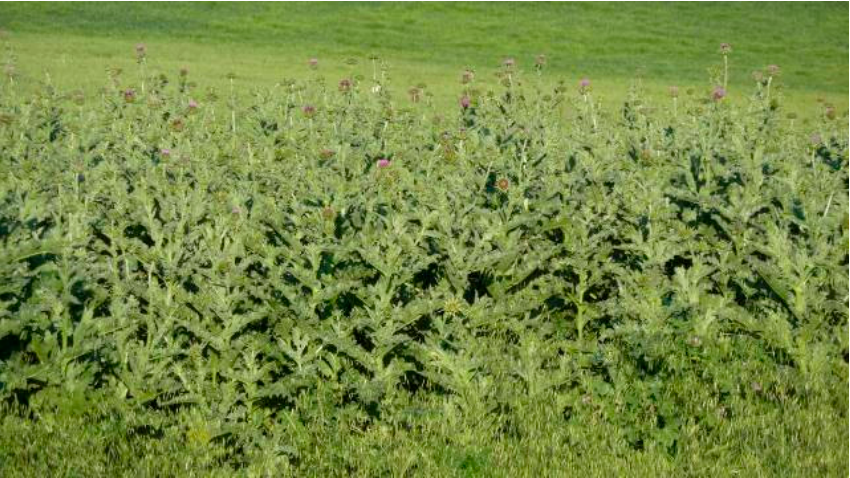
Figure 2 . Photo of S. marianum patch in the study area, taken on 22 April 2016.